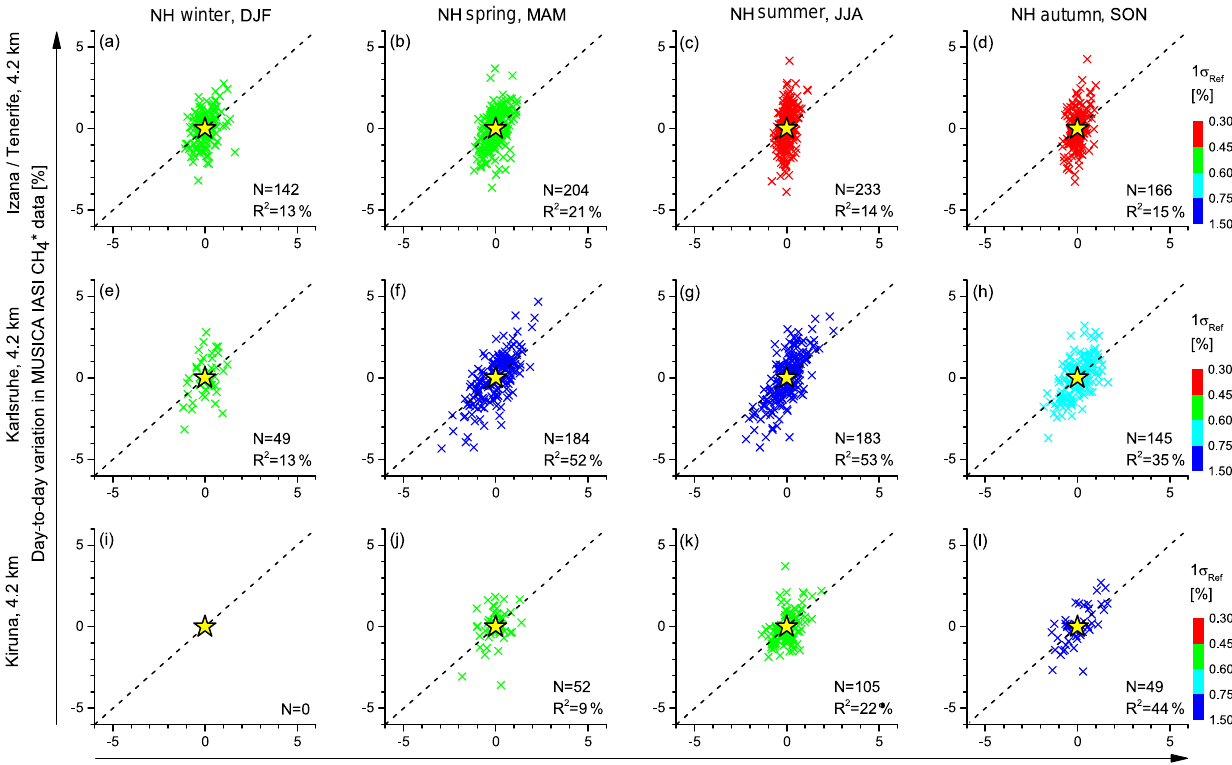
Figure 21. Same as Fig. 20, but for MUSICA IASI products (4.2km retrieval) and coinciding NDACC FTIR product (4.2km retrieval): (a– d) for the surroundings of Tenerife Island; (e–h) for the surroundings of Karlsruhe; (i–k) for the surroundings of Kiruna; (a) , (e) and (i) for northern hemispheric winter; (b) , (f) and (j) for spring; (c) , (g) and (k) for summer; and (d) , (h) and (l) for